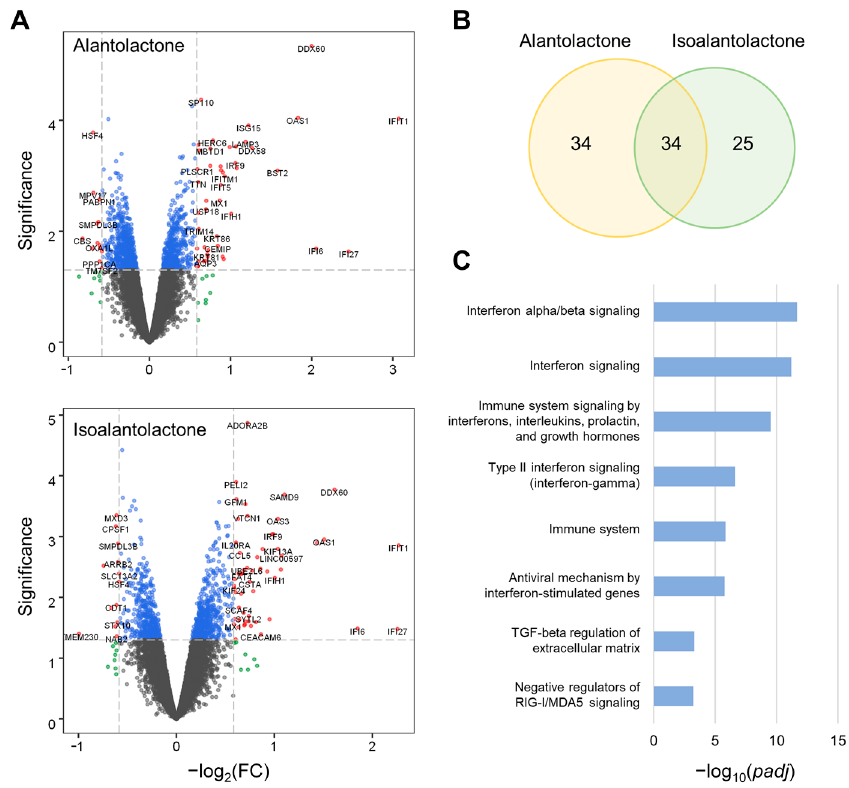
Figure 2. Predicted target pathways of alantolactone and isoalantolactone. ( A ) Volcano plots for the gene expression profiles in response to treatment with alantolactone or isoalantolactone in MCF-7 cells. The significance was calculated by − log 10 ( p -value). DEGs were selected with threshold p < 0.05 and |FC| >1.5. ( B ) Venn diagram for the number of differentially expressed genes (DEGs) from alantolactone and isoalantolactone treatment. ( C ) Significantly enriched pathways ( padj < 0.01) associated with the DEGs of the two phytochemicals by enrichR using BioPlanet_2019. FC, fold change; padj , adjusted p -value.